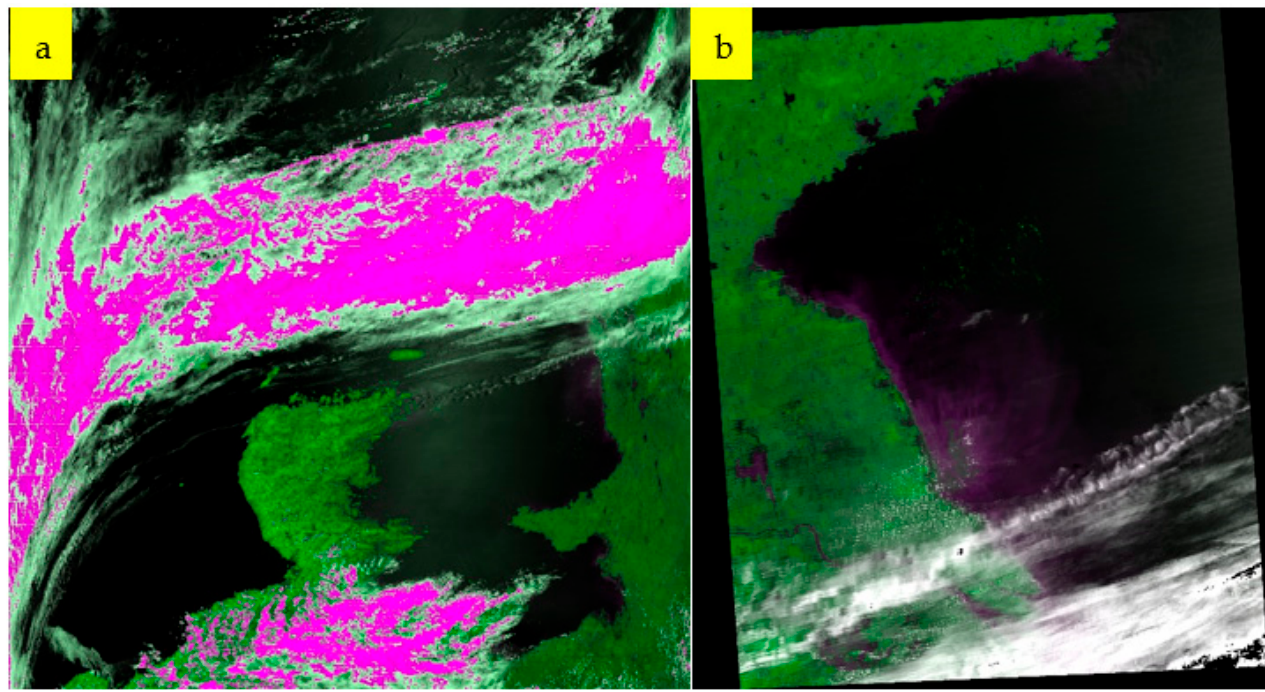
Figure 2. Flow chart of MODIS image preprocessing.